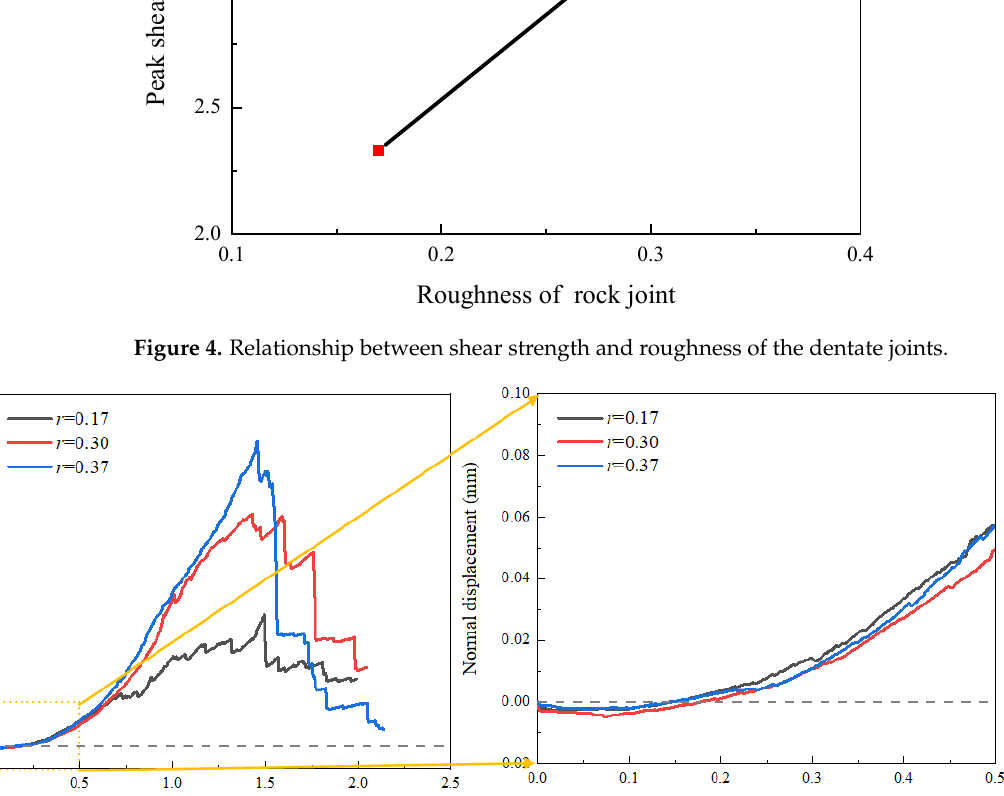
Figure 5. Normal displacement versus shear displacement curve of dentate joints with different